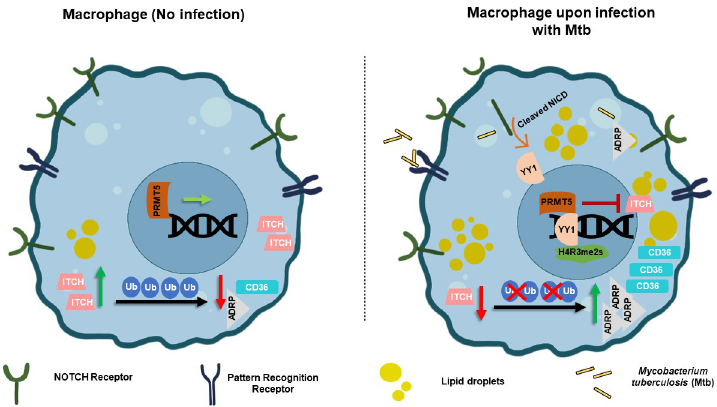
Fig 7. Model: Mycobacteria utilizes YY1-PRMT5 axis to repress ITCH and facilitate lipid accumulation.